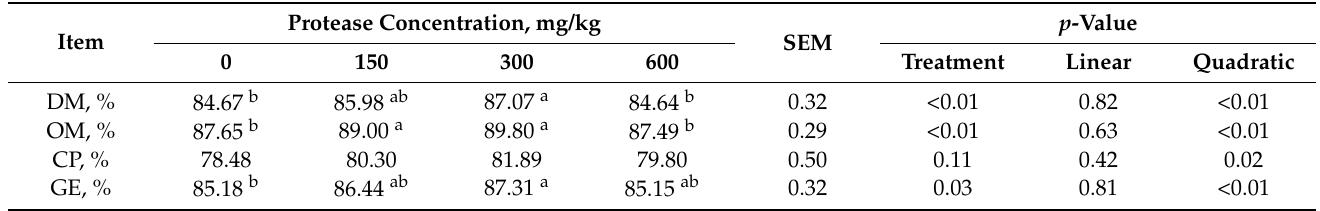
Table 5. Effects of protease supplementation on apparent total tract digestibility (ATTD) in weaned piglets.